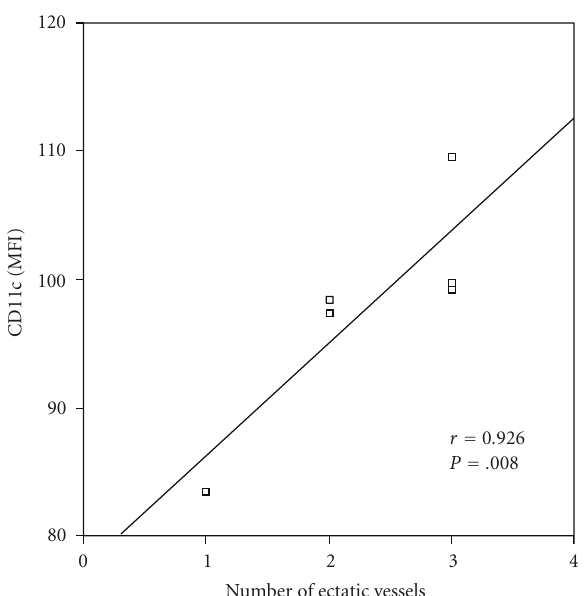
Figure 3: The graph showing the relationship between the number of ectatic vessels and the expression level of CD86 molecule. r : Spearman’s rho correlation coe ffi cient. MFI: mean fluorescence intensity. MFI: mean fluorescence intensity.